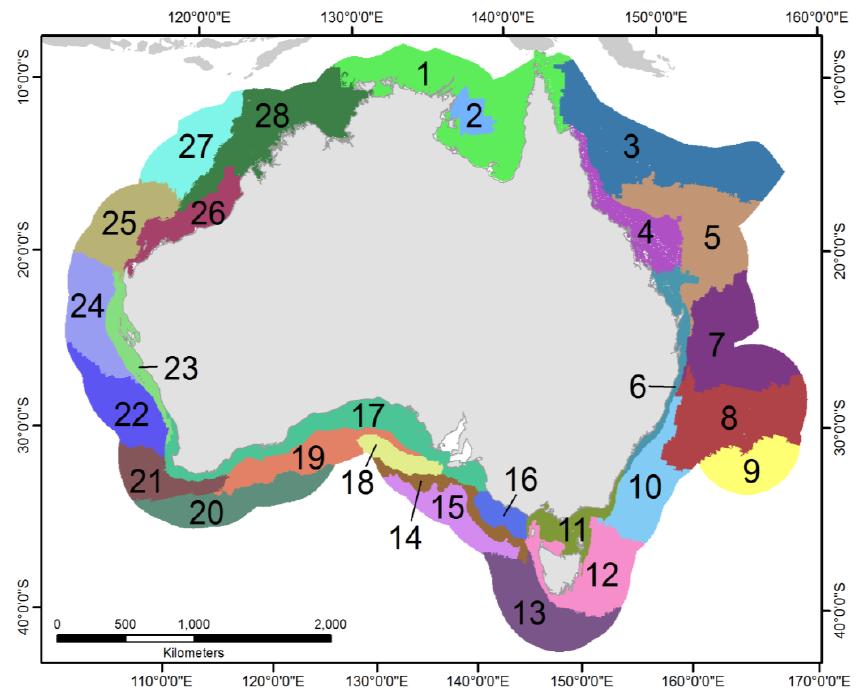
Figure A1. Acoustic zones after geographically separated zones were split and given a new zone label. Table A1. Average parameters ( SD) of the 28 spatially separated acoustic zones: Water depth, seafloor slope, sediment thickness, compressional (c p ) and shear (c s ) speeds, compressional ( 𝛼 p ) and shear ( 𝛼 s ) absorption coefficients, and density. 𝜆 is the acoustic wavelength. Split Zone